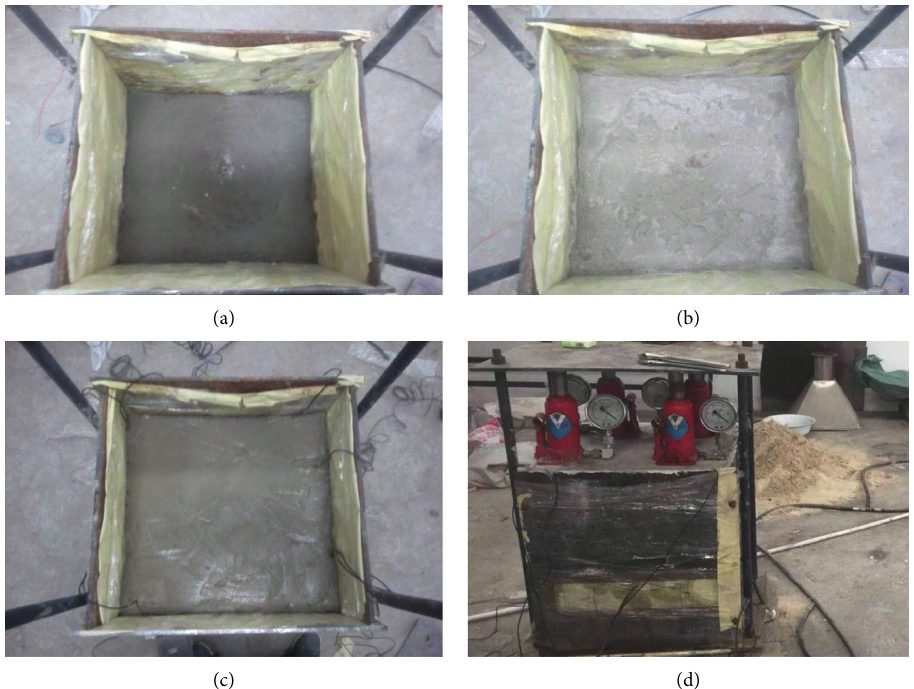
Figure 5: Construction process for similar model. (a) Construction of floor. (b) Construction of coal seam. (c) Construction of roof. (d) The whole model.